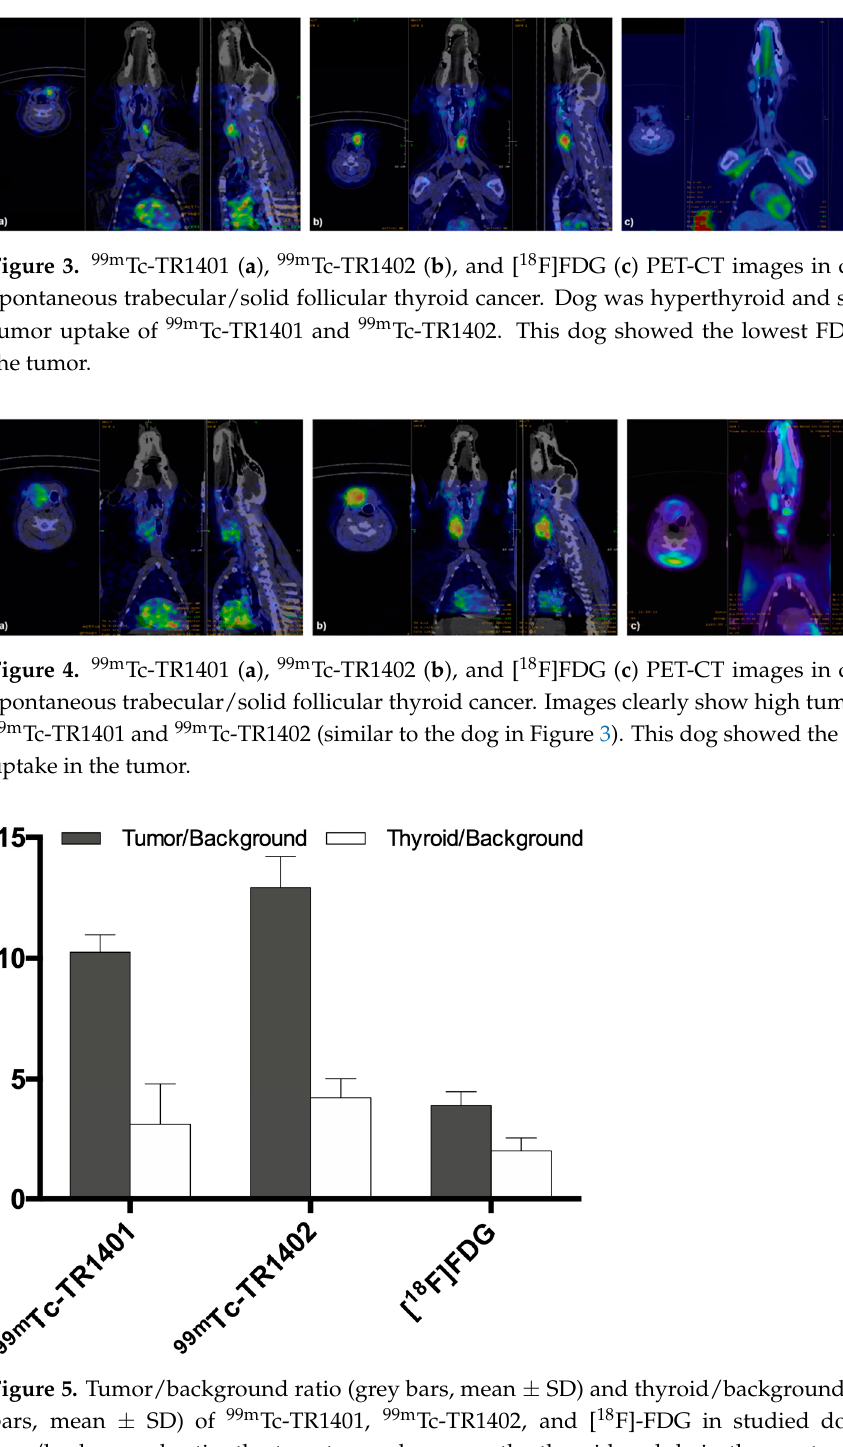
Figure 3. 99m Tc-TR1401 ( a ), 99m Tc-TR1402 ( b ), and [ 18 F]FDG ( c ) PET-CT images in dog 1 with a spontaneous trabecular/solid follicular thyroid cancer. Dog was hyperthyroid and showed high tumor uptake of 99m Tc-TR1401 and 99m Tc-TR1402. This dog showed the lowest FDG uptake in the tumor.